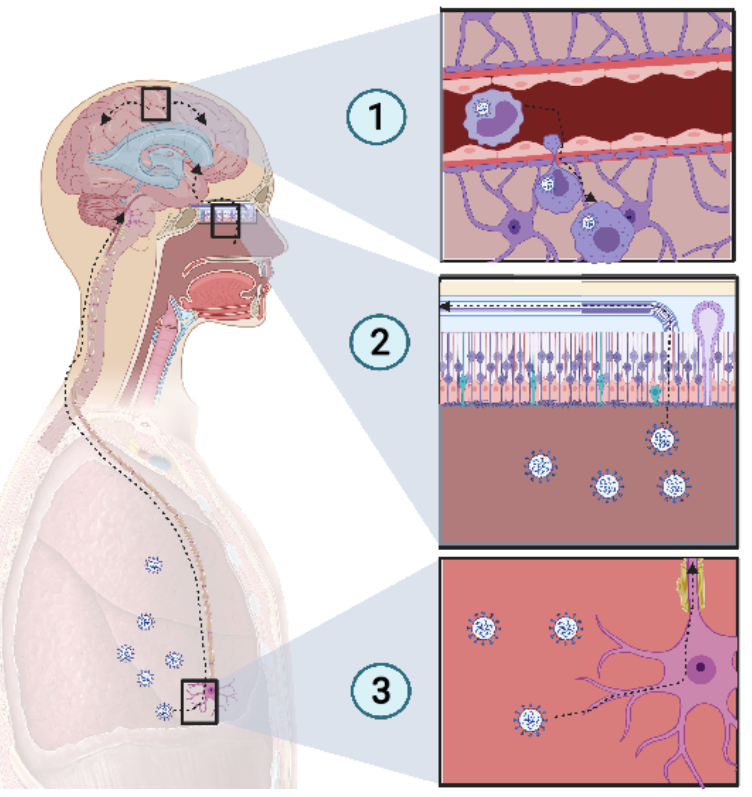
Figure 2. Potential mechanism of CNS invasion by SARS-CoV-2. ( 1 ) The blood − brain barrier (BBB) permits a limited exchange, due to the continuous capillary endothelium, with a tight junction supported by continuous basement mem- brane and surrounded by astrocyte feet. Monocytes infected with SARS-CoV-2 act as Trojan horses, due to their access to the CNS. Thus, an extravasation of infected monocytes can promote CNS infection. ( 2 ) The high-spectrum olfactory recep- tors expressed on the cilia of olfactory neurons may act as receptors for SARS-CoV-2, thus infecting the bipolar neuron in the nasal epithelium. Retrograde movement leads SARS-CoV-2 to the olfactory bulb, which is connected to the limbic system, thus promoting the invasion of the limbic system, including the hippocampus . ( 3 ) Chemoreceptive neuron infec- tion in the lower respiratory tract may lead to a retrograde migration of the virus through the nervous network toward the respiratory center in the brain stem, resulting in acute respiratory failure . Created with BioRender.com